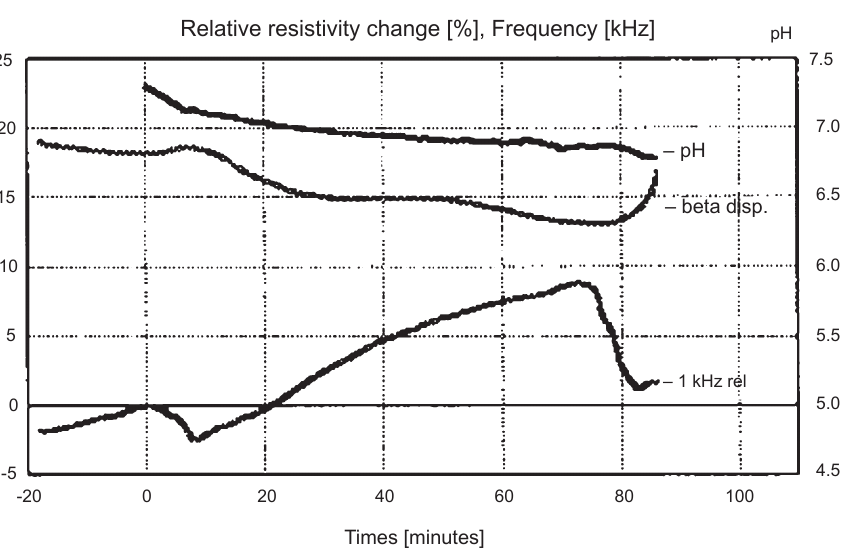
Fig. 4. Typical measured resistivity, pH and beta dispersion over time after the onset of ischemia. Beta dispersion is a measure of the change of capacitance.Tissueistheisolatedtibialisanteriormuscleofarabbithindleg.Theocclusionofthearterywasremovedat72minutes.Reproduced from [24]. Additional plots showing the relationship between impedance and ischemia can be found in